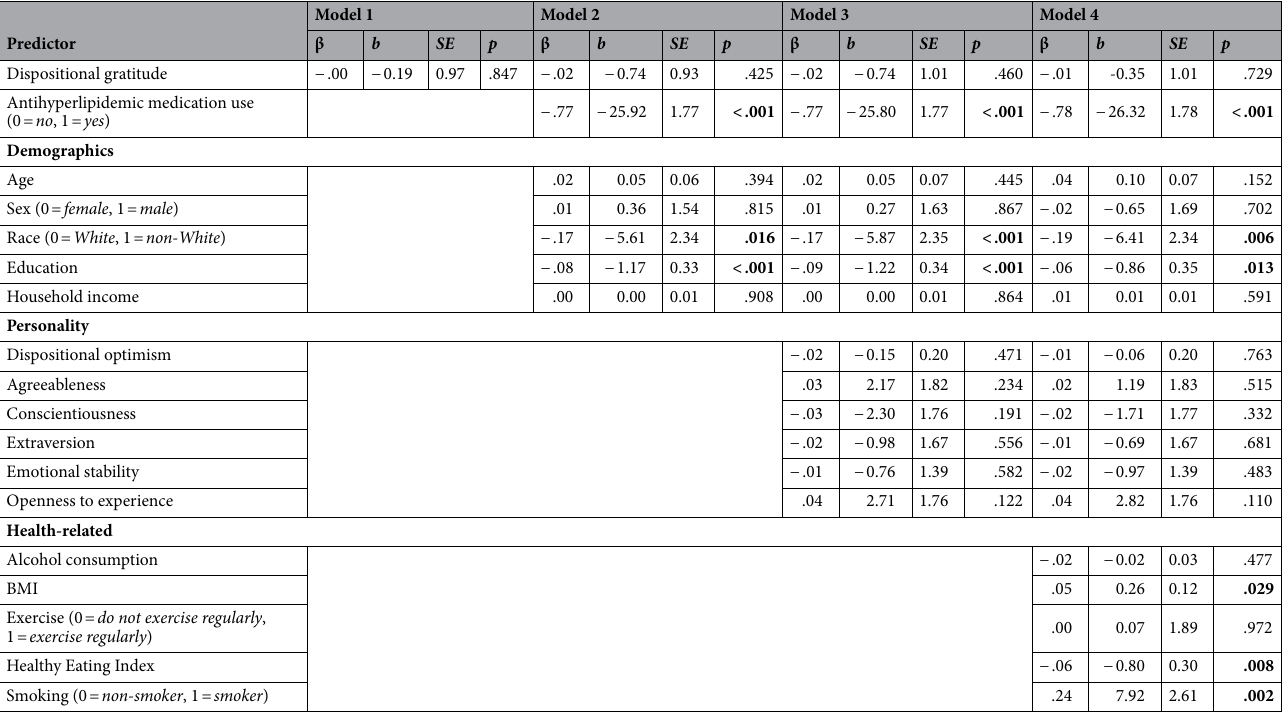
Table 3. Model summaries with LDL as the outcome variable. N = 1800. β = standardized slope coefficient, b = unstandardized slope coefficient, SE = standard error of the slope coefficient. Bolded p -values indicate statistical significance at the .05